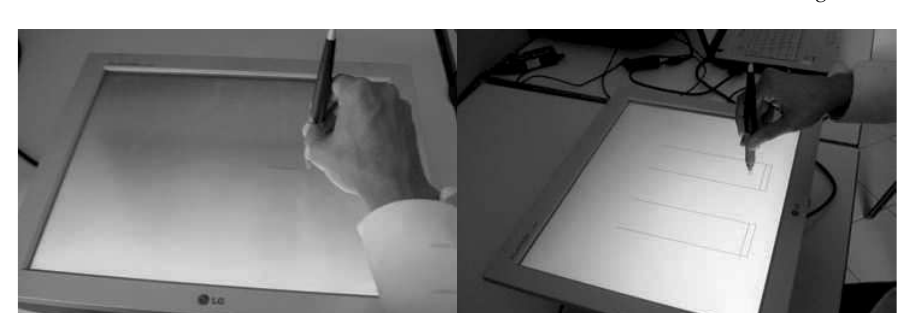
Fig. 2. Tracing the lineograms (on the left) and parallels (on the right). Source : Photos by Liutsko L. (Own